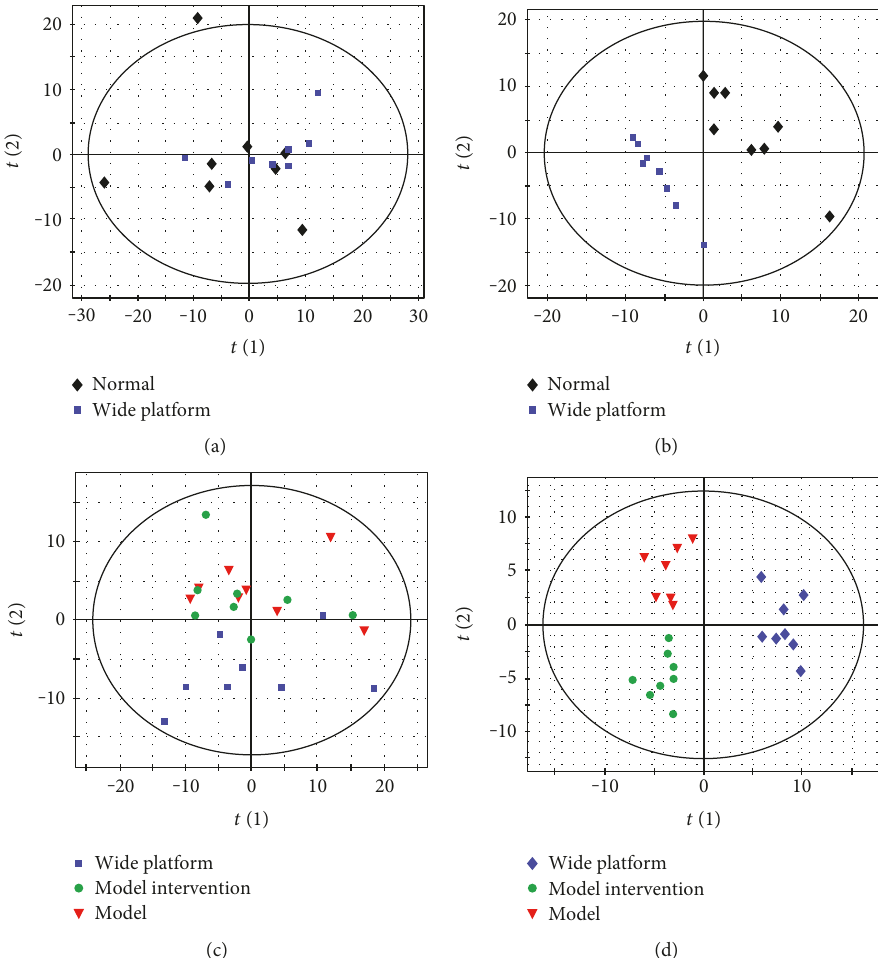
Figure 3: Score plots of multivariate statistical analysis on brain tissues. (a) PCA score plot of normal group versus wide platform (WP), (b) PLS-DA score plot of normal group versus wide platform (WP) group, (c) PCA score plot of WP, M, and model with GS intervention (MGS) groups, (d) PLS-DA score plot of WP, M, and MGS